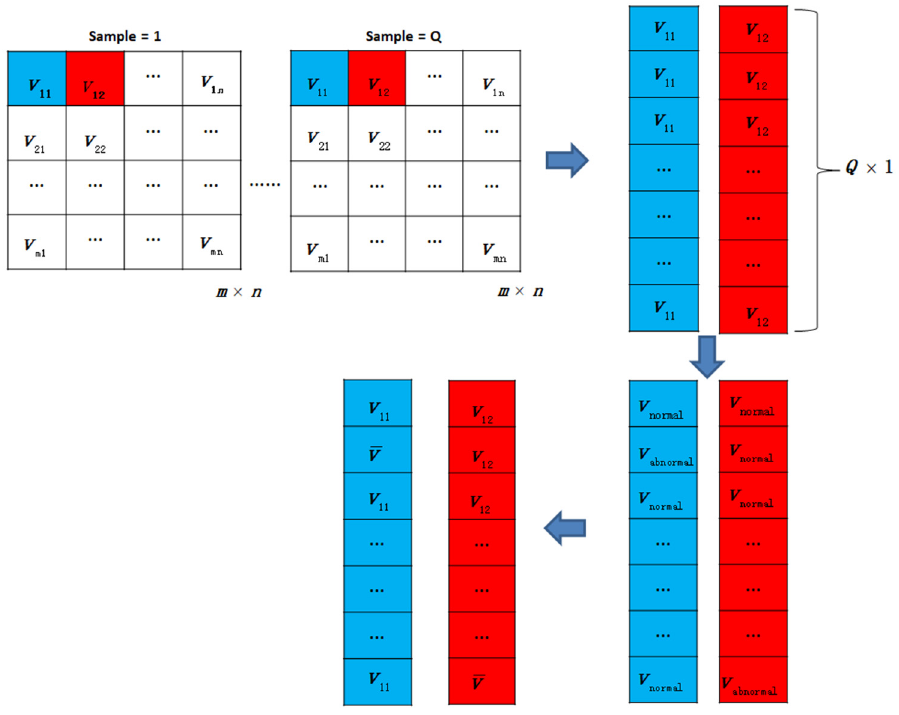
Figure 7. Values’ selection and enhancement process.